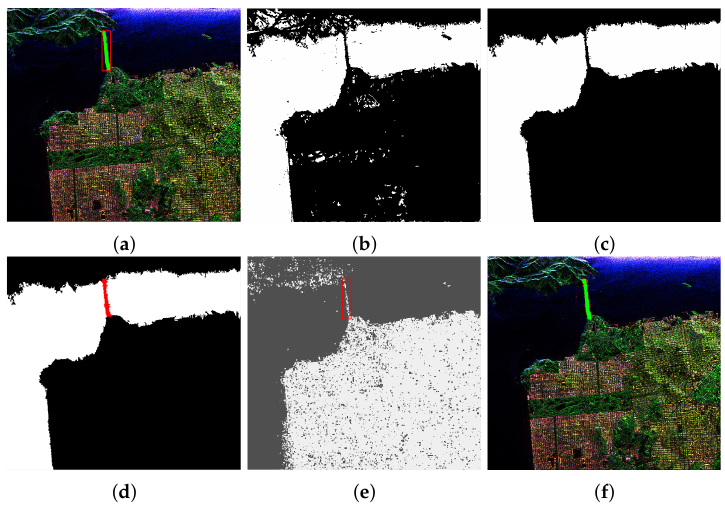
Figure 4. Sea-crossing bridge detection results of the data of AirSAR San Francisco. ( a ) Pauli pseudo- color image and ground-truth of bridges, where green pixels in red boxes are the marked bridge region. ( b ) The result of sea–land segmentation using the windowed level set method. ( c ) The result of sea–land segmentation after the post-processing of area thresholding. ( d ) The result of sea–land segmentation after water merging, where the red pixels are the recognized ROI. ( e ) The high-entropy and high-scattering angle regions by the H / α thresholding segmentation, where the recognized ROI is marked in a red box. ( f ) The final bridge detection result, where the red pixels are the detected bridge and the green pixels are the